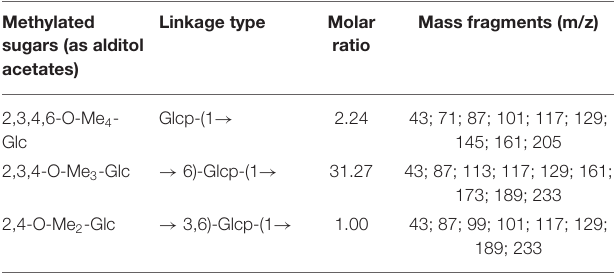
TABLE 1 | GC–MS data of alditol acetate derivatives from the methylated product of MDP. Methylated sugars (as